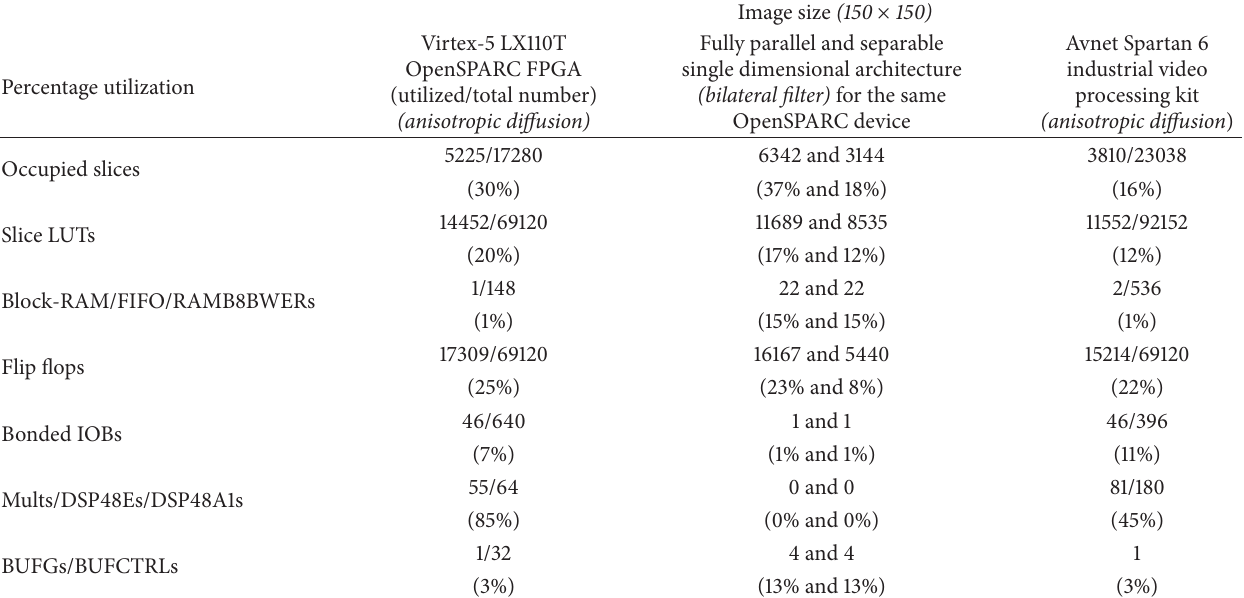
Figure 22: The figure shows the frame processing rate of software and hardware processing platform. 𝑥 -axis denotes the image resolutions and 𝑦 -axis the frames per second, respectively, for image of different resolutions as shown from 1 to 3 in 𝑥 -axis. Table 4: Comparison showing resource utilization of the various optimized hardware architectures for image resolution 150 × 150 implemented in Virtex-5 LX110T OpenSPARC Evaluation Platform [28] and Spartan 6 IVK [29] realizing bilateral [12] and anisotropic diffusion